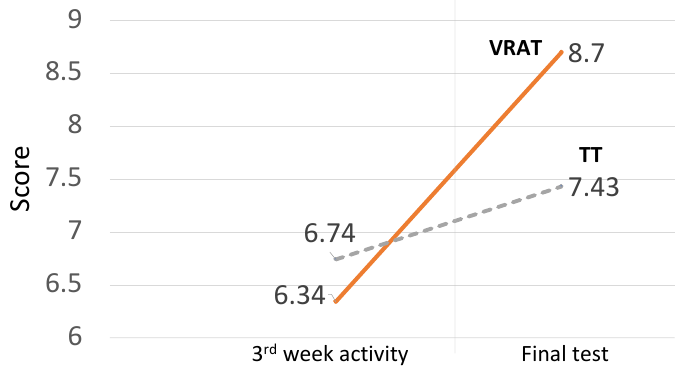
Figure 9. Knowledge improvement measurement.